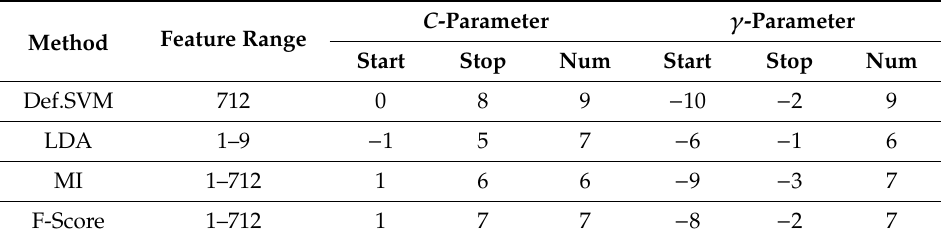
Table 5. Parameter grid for the exhaustive grid search